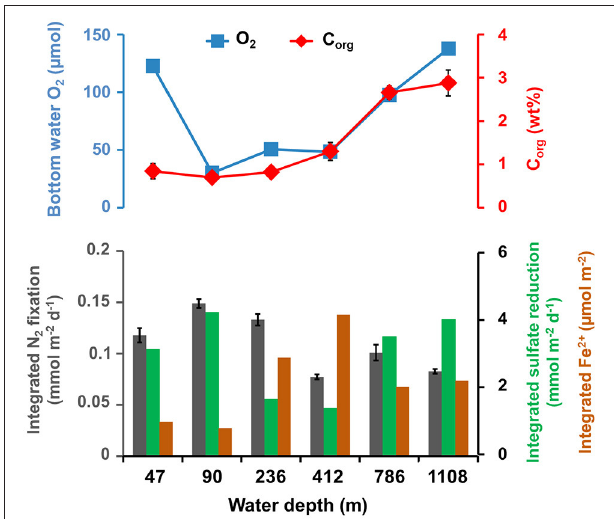
FIGURE 6 | Top : Bottom water O 2 ( µ M) and average (0–20 cm, n = 10–20) particulate organic carbon content (C org , wt%) along the depth transect. Bottom : Integrated nitrogen fixation (mmol N 2 m − 2 d − 1 , gray bars, average of three replicates plus standard deviation), sulfate reduction rate (mmol SO 2 − 4 m − 2 d − 1 , green bars, single measurements) and average ferrous iron concentration (Fe 2 + , µ mol m − 2 , brown bars) between 0 and 20 cm along the depth transect (m).